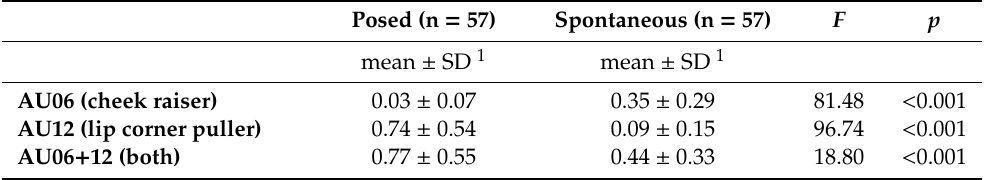
Table 3. Comparative mean AU according to different type of smile expression.